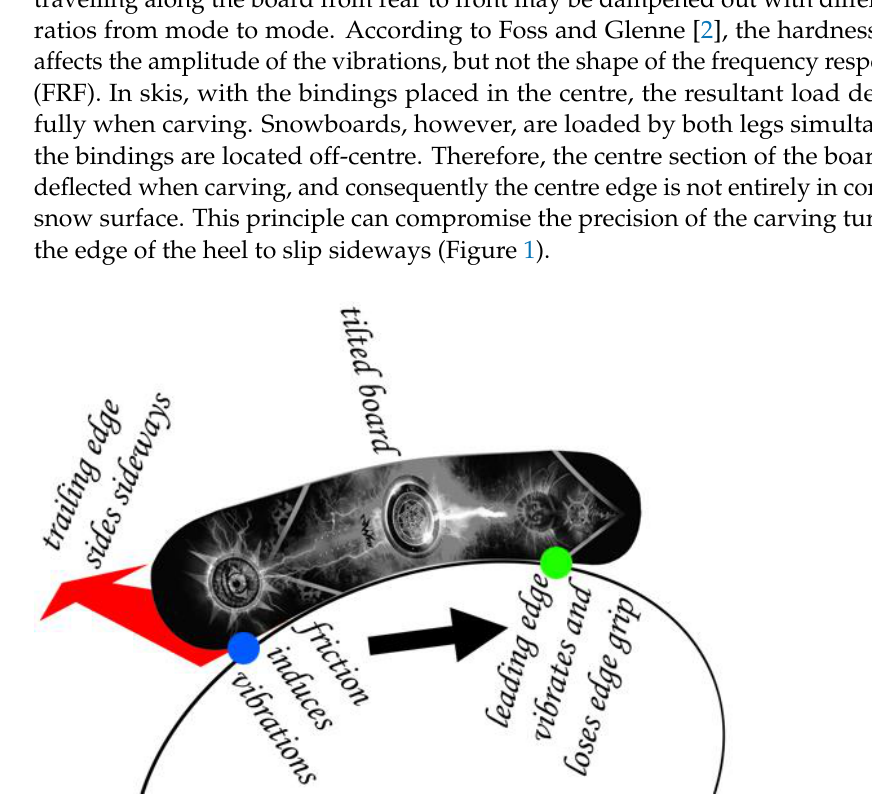
Figure 1. Principle explaining loss of stability and edge control; red arrow: sliding direction of the trailing edge; blue dot: last point of the trailing edge in contact with the snow; green dot: first point of the leading edge in contact with the snow.